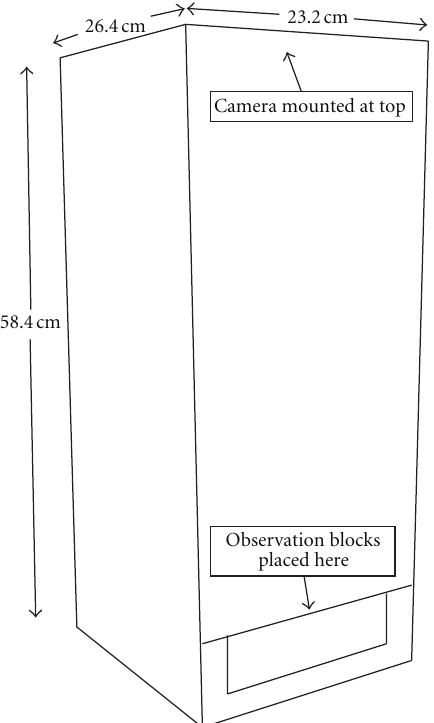
Figure 1: Diagram of camera housings for recording intranest behavior of O. cornifrons . The frame was made of white pine timber, and the walls were made from Masonite boards. The camera was mounted to the lid and faced down toward the observation blocks. A small groove was cut into the back of the frame to allow space for the camera cord.